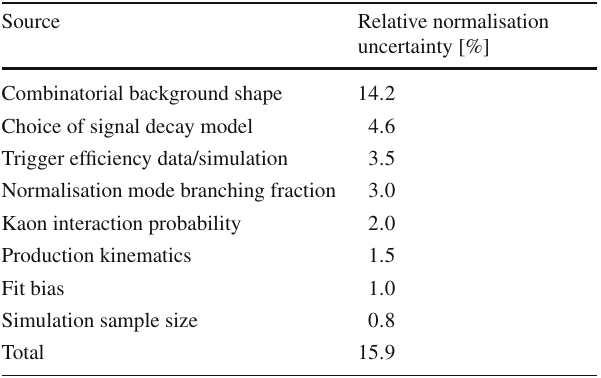
Table 1 Summary of systematic uncertainties. Numbers are on the relative uncertainty of the normalisation for the branching fraction